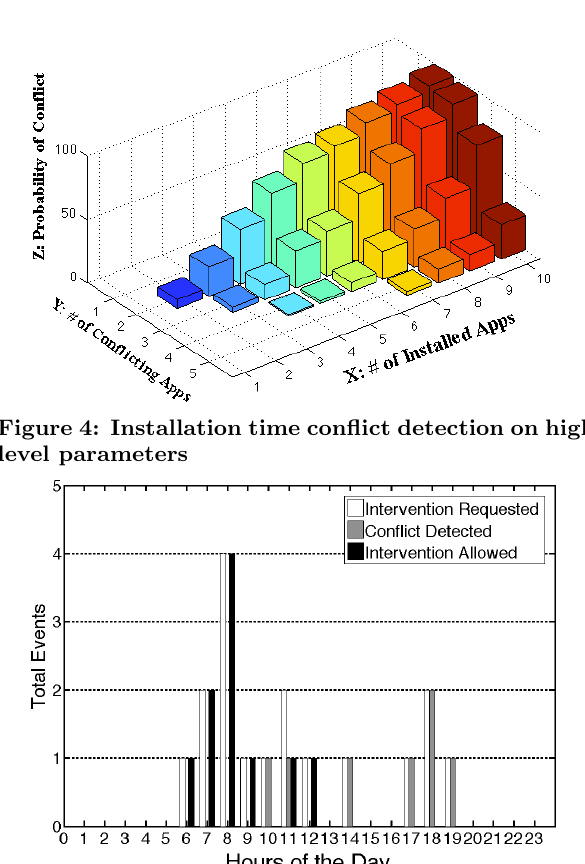
Figure 6: Runtime conflict detection on high level